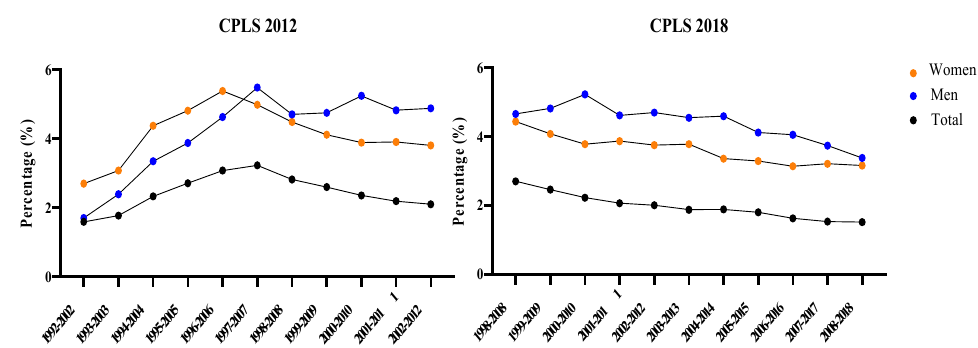
Figure 5. Variation in the average salary in 10-year periods in people aged 20 to 30 years who have reached higher education, Spain (1992–2018). Source: Our own elaboration from the Spanish CPLS 2012 and 2018.